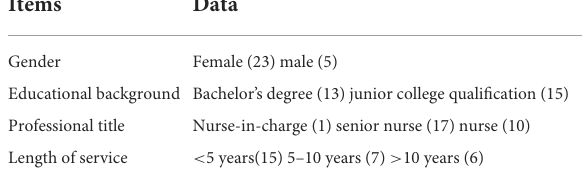
TABLE 1 Demographic data of the participants.